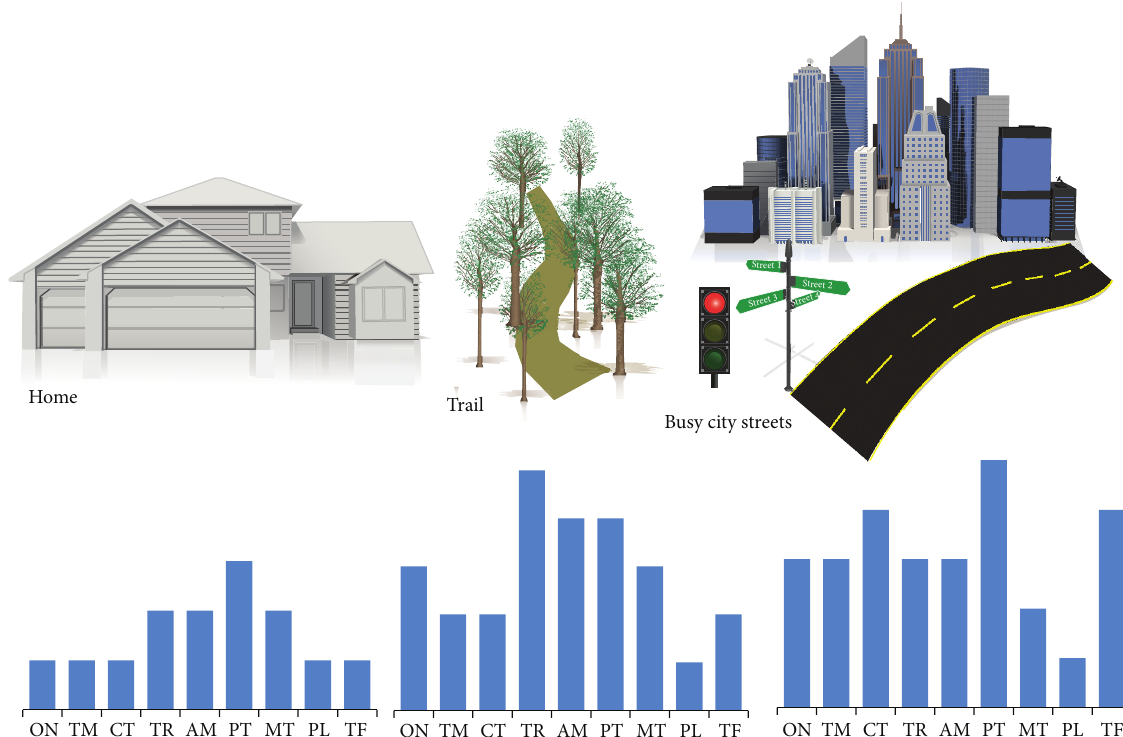
Figure 2: Conceptual illustration of the domains of adaptability. This figure illustrates the relative demands that may be placed on the nine domains of walking adaptability in different ambulatory environments. The nine domains of walking adaptability have been adapted from earlier work by Patla and Shumway-Cook [15]. In a less complex and predictable environment such as the home, the requirements for walking adaptability would be less demanding and encompass fewer domains relative to more challenging environments such as walking on a nature trail or on a busy city street. Abbreviations: ON—obstacle negotiation; TM—temporal demands; CT—cognitive dual-tasking; TR—terrain